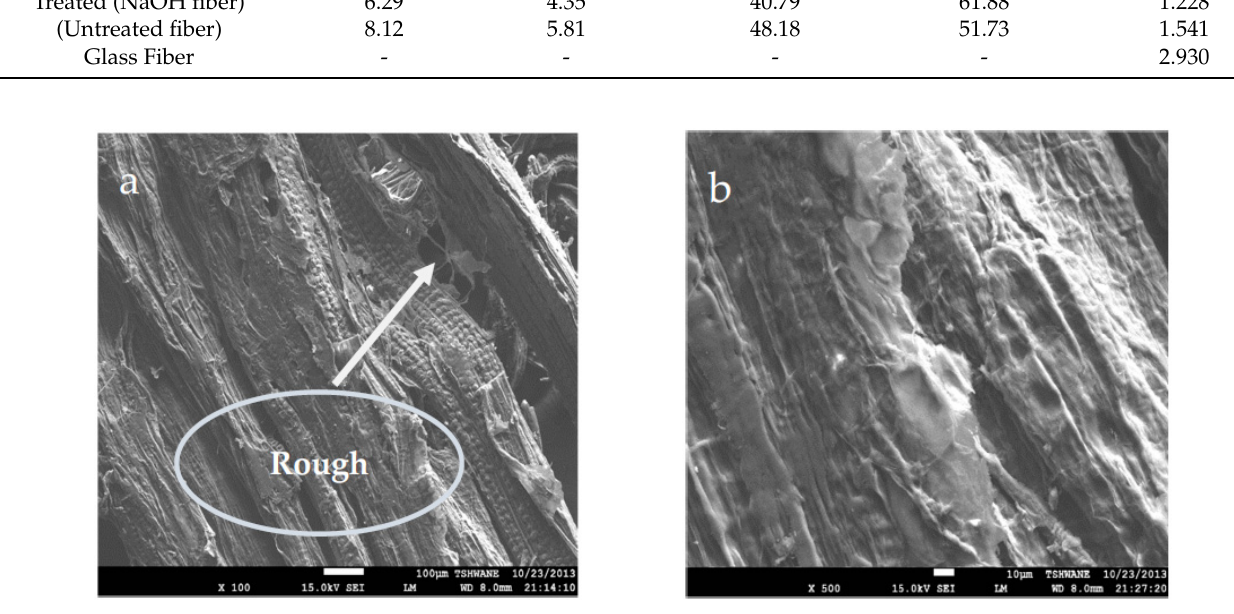
Figure 2. Chemical treatment of the fiber: ( a ) NaOH treated fiber; ( b ) Untreated fiber.